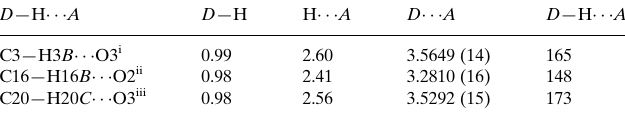
Hydrogen-bond geometry (A˚ , (cid:3)